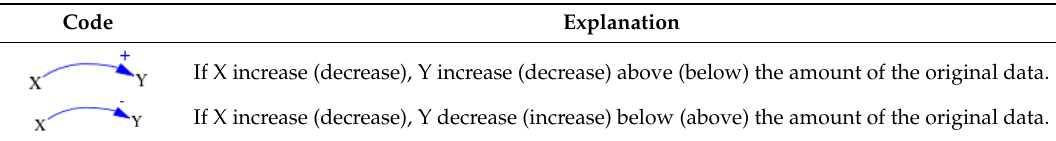
Table 7. Polarity of the causal chain.